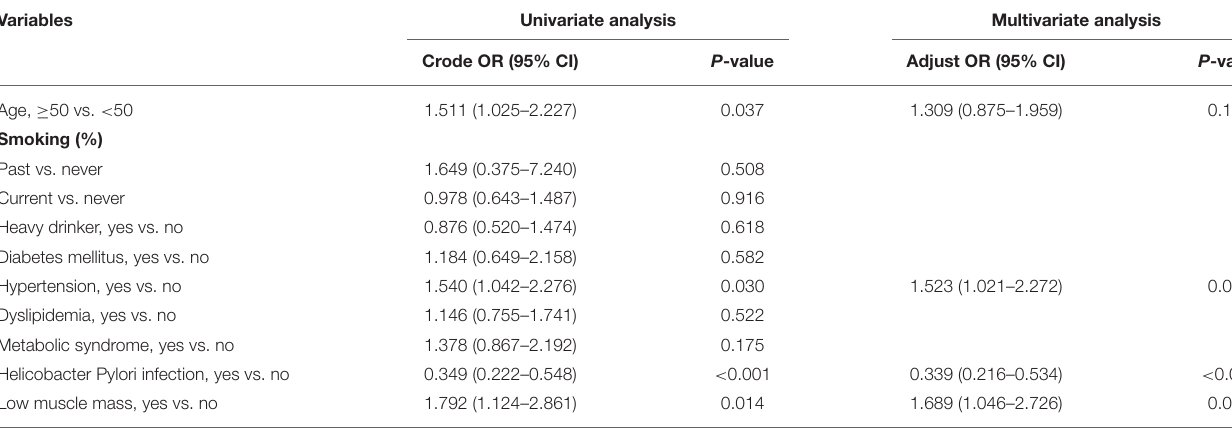
TABLE 3 | Univariate and multivariate analyses for gastric polyps.